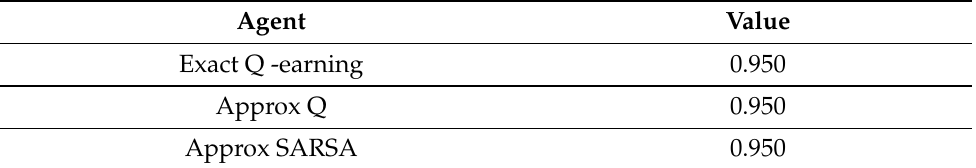
Table 5. γ (factor for discount).